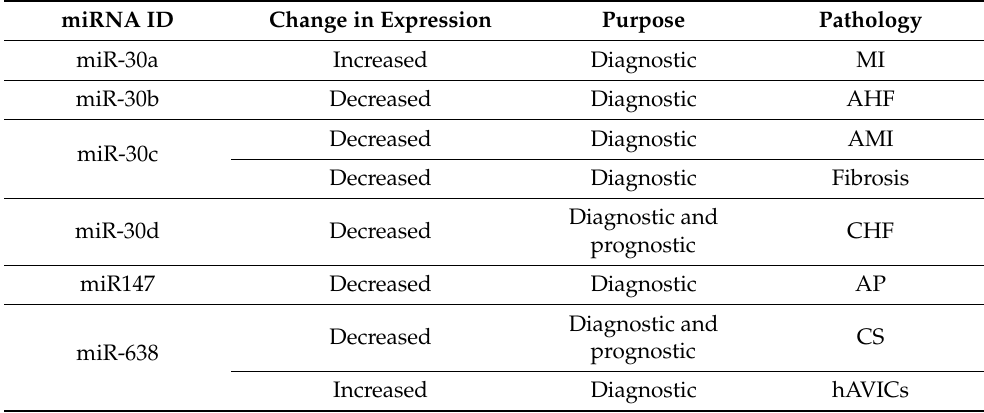
Table 3. Diagnostic and prognostic role of various the miRNAs (miR-30, miR-147b and miR-638) associated with cardiovascular disorders